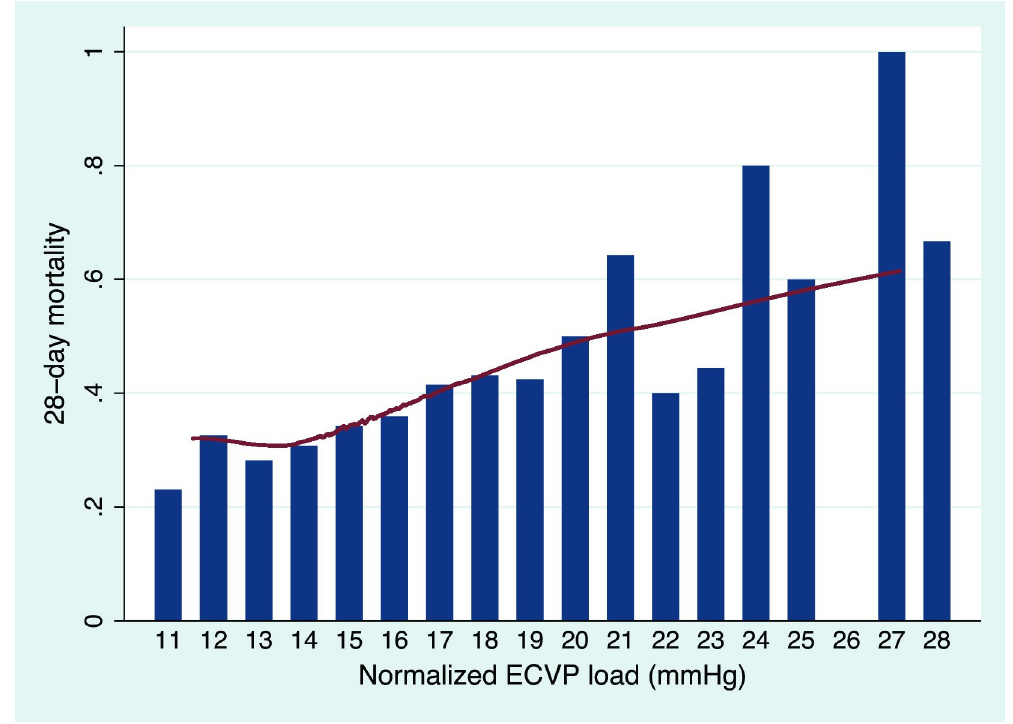
Fig 3. Mortality rate in patients with different normalized elevated central venous pressure load. The bar plot demonstrates the raw mortality rate in each patient subgroup with different normalized elevated central venous pressure (ECVP) load. Locally weighted smoothing (Lowess Smoothing) showed a linear relationship between normalized ECVP load and mortality rate. Note that the number of patients with a normalized ECVP load equals 26 mmHg was zero.